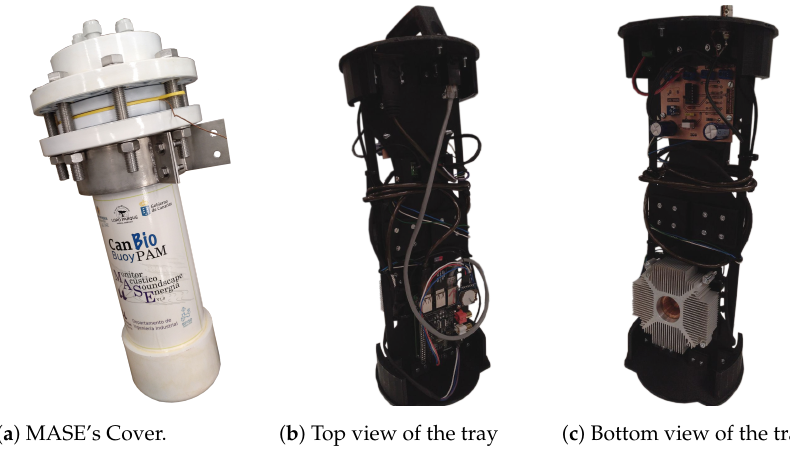
Figure 6. MASE’s final